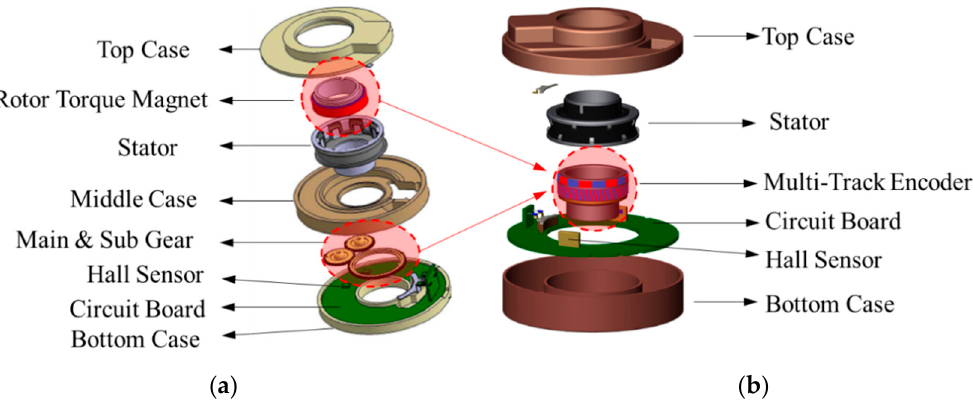
Figure 1. ( a ) Conventional torque angle sensor and ( b ) proposed torque angle sensor based on MTE schematic.